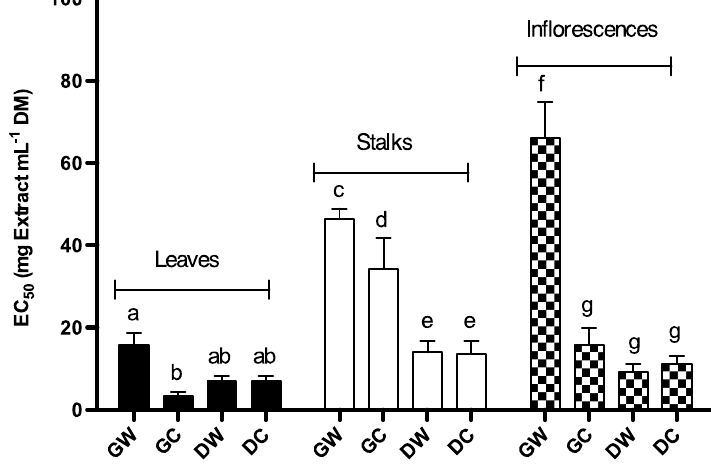
Figure 3. DPPH free radical scavenging capacity of Cc methanolic extracts, expressed in . Each value represents the mean ± S.D. of three determinations. At least one terms of EC 50 same letter means no significant differences at P ≤ 0.05. Abbreviations: GW: green wild; GC: green cultivated; DW: dry wild; DC: dry